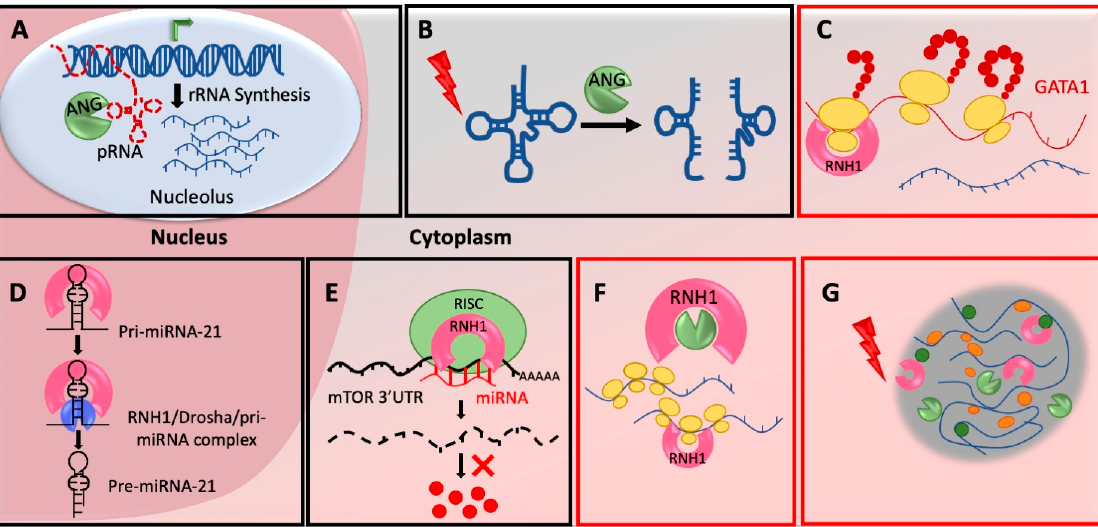
Figure 1. Mechanisms of ANG-RNH1 mediated translational regulation: ( A ) ANG regulates rRNA synthesis in nucleolus—ANG cleaves pRNAs in the nucleolus to de-repress the rDNA transcription, activates rRNA production and subsequently enhance global protein synthesis by increased ribosome biogenesis. ( B ) ANG cleave tRNAs in cytoplasm—ANG in response to various stresses cleave tRNAs in cytoplasm to produce tiRNAs, which ultimately inhibits translation initiation. ( C ) RNH1 regulates mRNA specific translation—RNH1 binds to 40S ribosomal subunits to possibly initiate translation on specific mRNAs ( D ) RNH1 controls miR-21 biogenesis in nucleus—RNH1 in the nucleus interacts with pri-miR-21 and the Drosha complex to enhance processing into mature miR-21. ( E ) RNH1 bind miRNAs and controls target repression—Cytoplasmic RNH1 interacts with miRNA machinery and recruits miR-99a, miR-99b, and miR-101 on 3 (cid:48) UTR of mTOR mRNA for its repression. ( F ) RNH1 binds polysomes and possibly stabilize them—RNH1 is present in polysome fractions and it might maintain the integrity of the polysomes possibly by scavenging RNases. ( G ) RNH1 and ANG present in stress granules—RNH1 and ANG are components of stress granules with unknown function. Mechanisms highlighted with red boxes are under explored and need further detailed mechanistic investigation. All schematics are representative and not to the